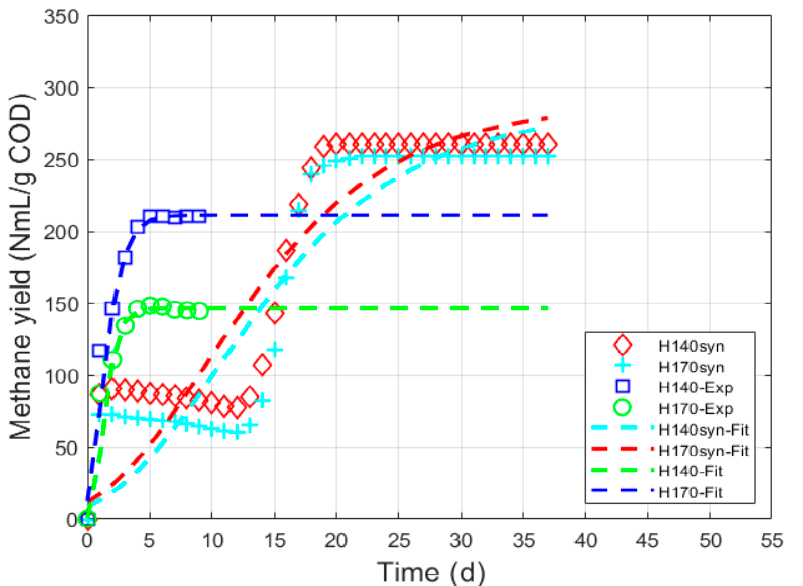
Figure 1. Modified Gompertz model (Equation (2)) fitted with cumulative methane yield of hydrolysates (real and synthetic) from AMPTS II. COD = chemical oxygen demand Table 5. Model parameters by the modified Gompertz model from cumulative methane production.